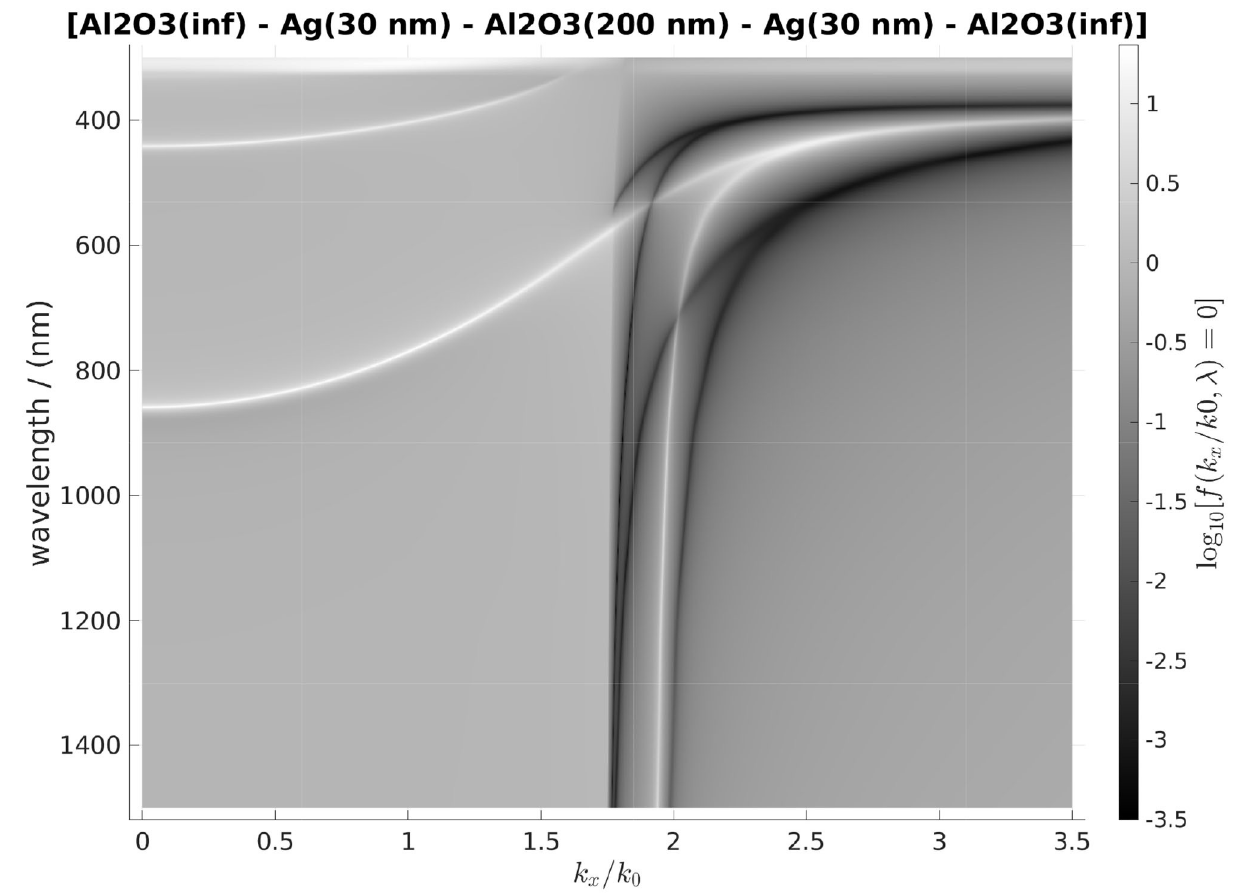
FIGURE 4 | Dispersion relation of the surface plasmon modes supported in a pair of silver films separated by a layer of aluminum oxide. The semi-infinite media embedding the three layers is also aluminum oxide. The dielectric constants for silver were taken from Johnson and Christy (1972). The dielectric function used for the aluminum oxide was based on the Sellmeier dispersion equation found by Malitson (1962). The tabulated optical constant values were extracted from the online database https://refractiveindex.info ( Polyanskiy, 2020). The dark regions correspond to the plasmon guided modes. Plasmon modes have always a k -vector k 0 n 1 , the propagation constant of the first medium. The bright lines in the left region denote the cavity modes for p-polarized larger then k 1 =